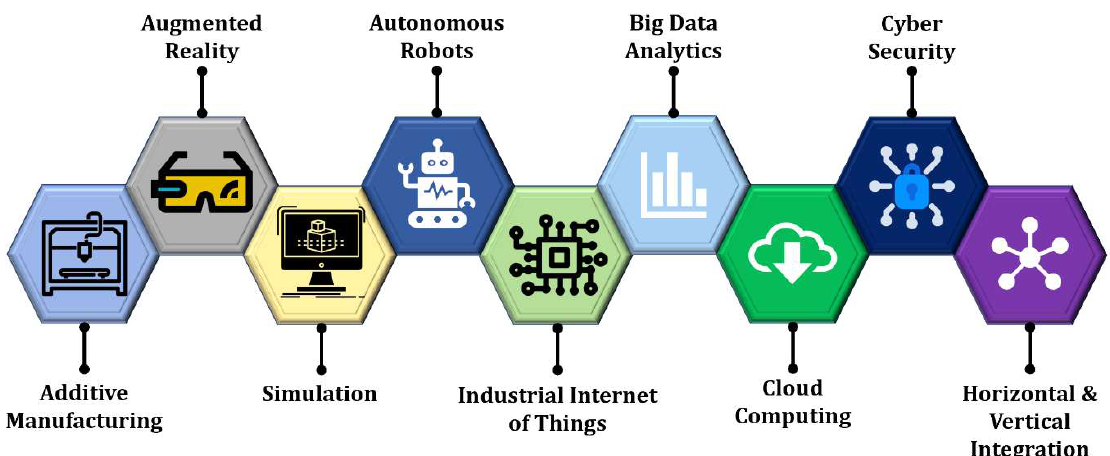
Figure 1. Enabling technologies of Industry 4.0.